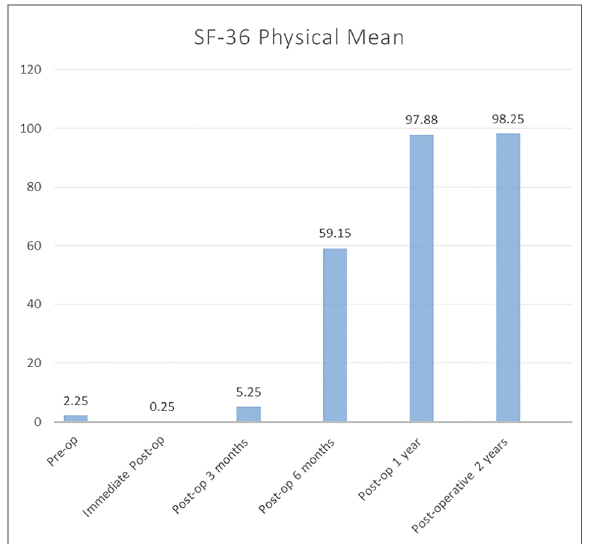
FIGURE 1 SF-36 physical component mean score for 2 years follow-up. SF-36, 36-Item Short-Form Health Survey.